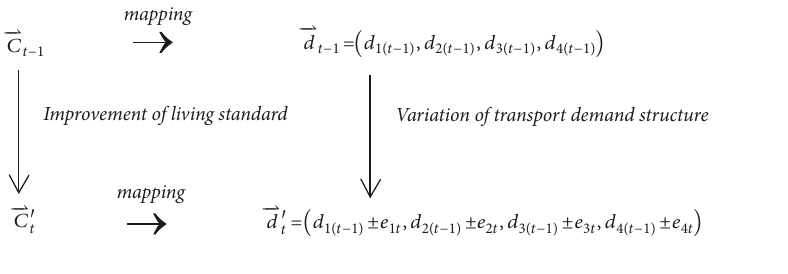
Figure 2: Mapping process from residents’ consumption structure to transport